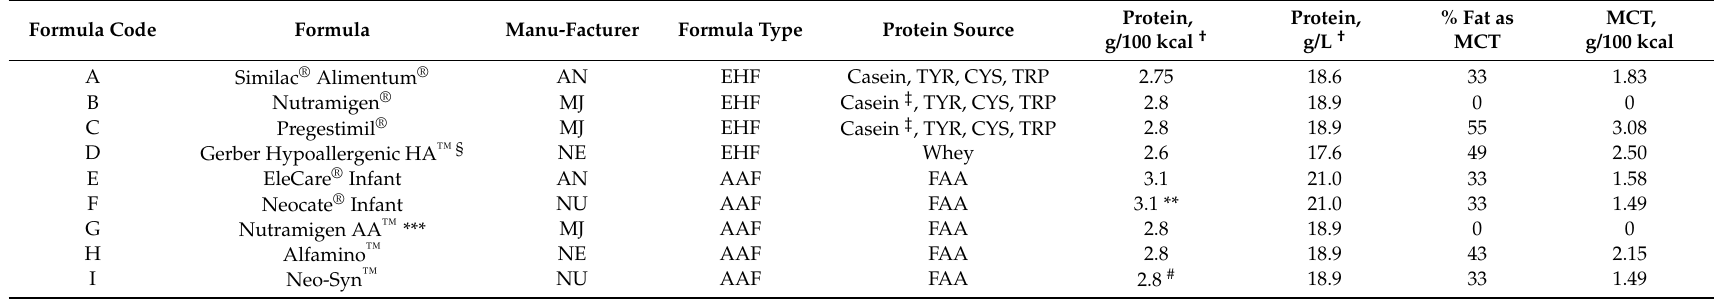
Table 1. Extensively Hydrolyzed Protein- and Amino Acid-Based Formulas Cited in this Review